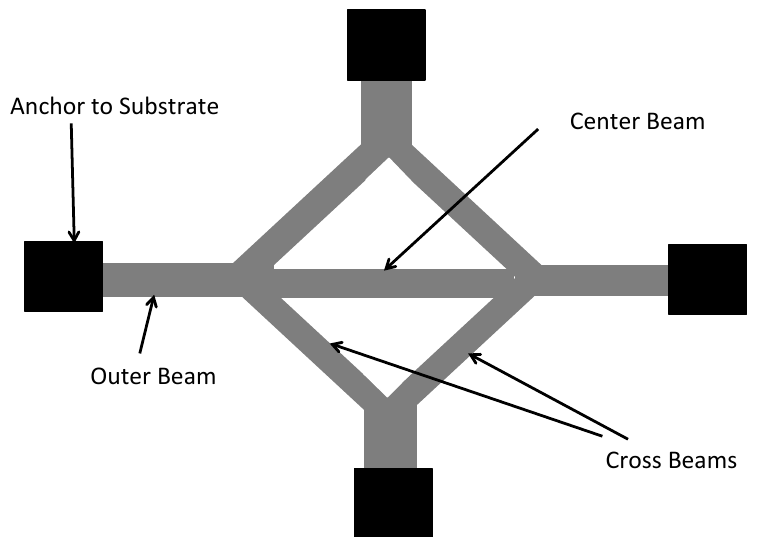
Figure 8. A Guckel ring residual stress test structure.